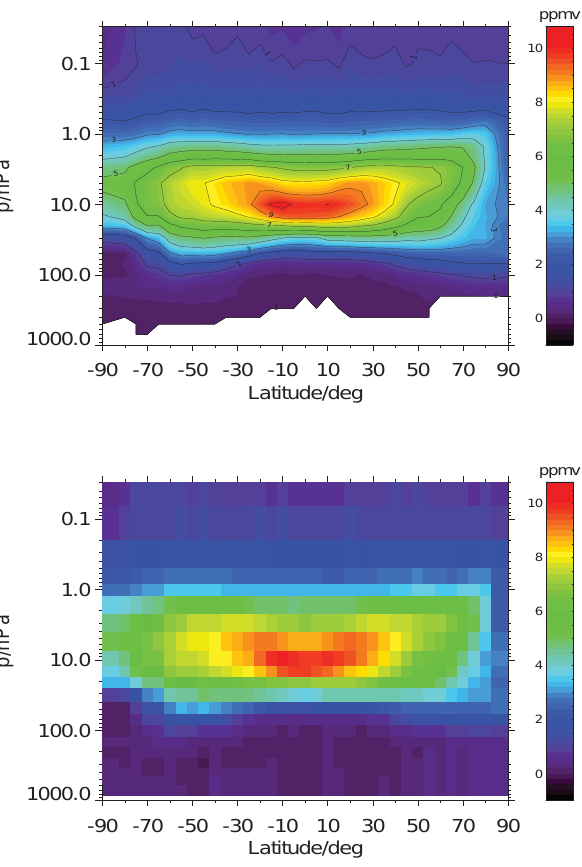
Figure 3. Zonal mean ozone distributions from the regular retrieval on a fine grid (top panel) and the maximum likelihood staircase representation on a coarse grid (bottom